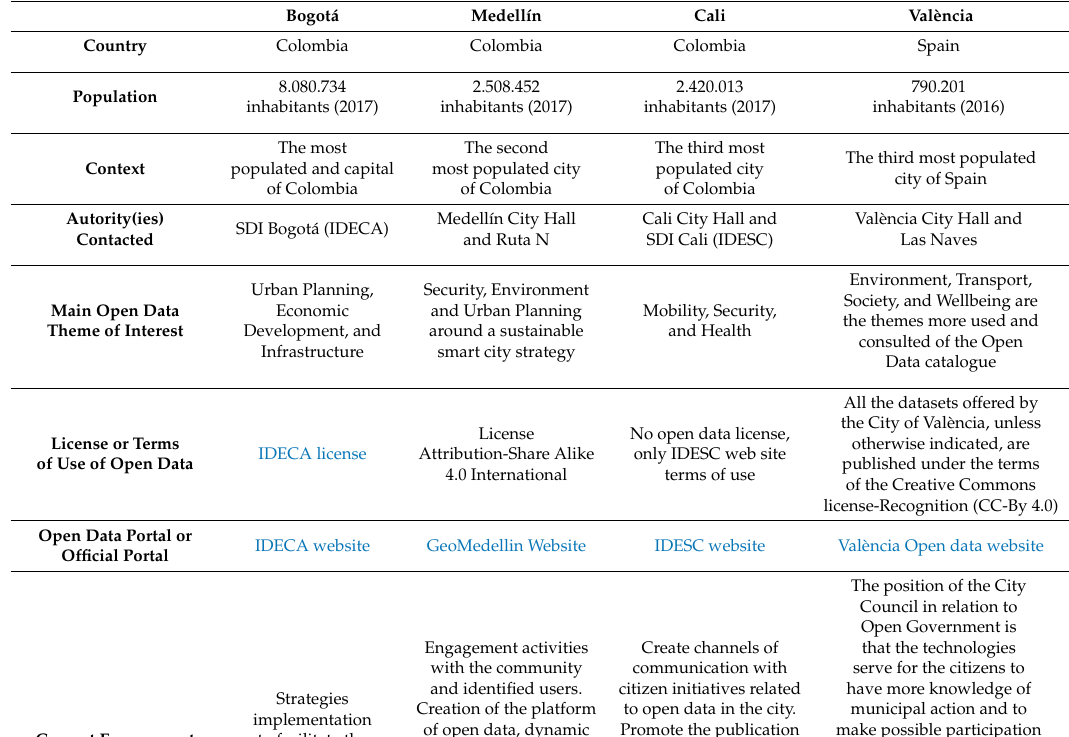
Table 1. General aspects of selected cities data authorities. IDECA: Infraestructura de Datos Espaciales para el Distrito Capital; IDESC: Infraestructura de datos espaciales de Santiago de Cali; SDI: spatial data